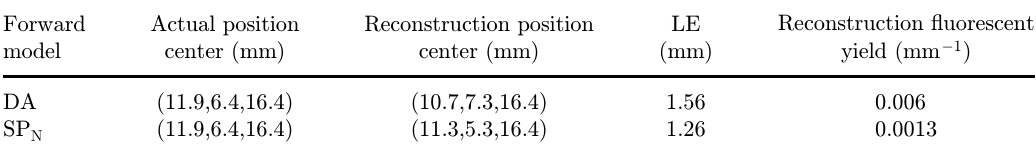
Table 2. Reconstructed results in single target case on the initial coarse mesh (highly scattering media).